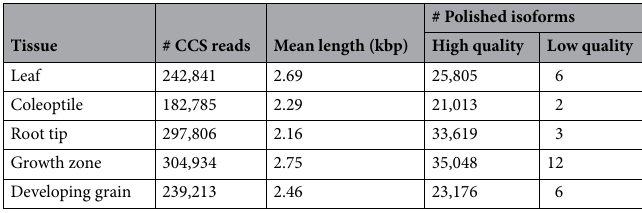
Table 3. Summary statistics of the Pac Bio Iso-Seq data.